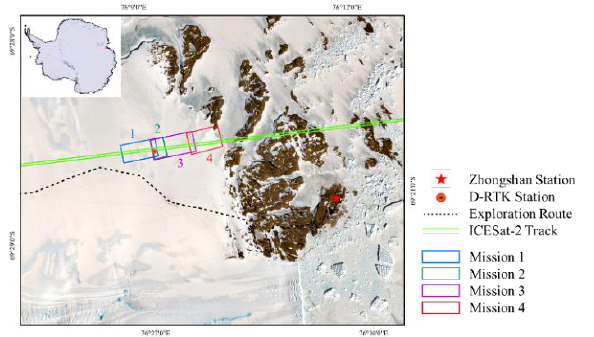
Figure 1 . Location of the UAV surveyed areas on the background of Landsat-8 images.